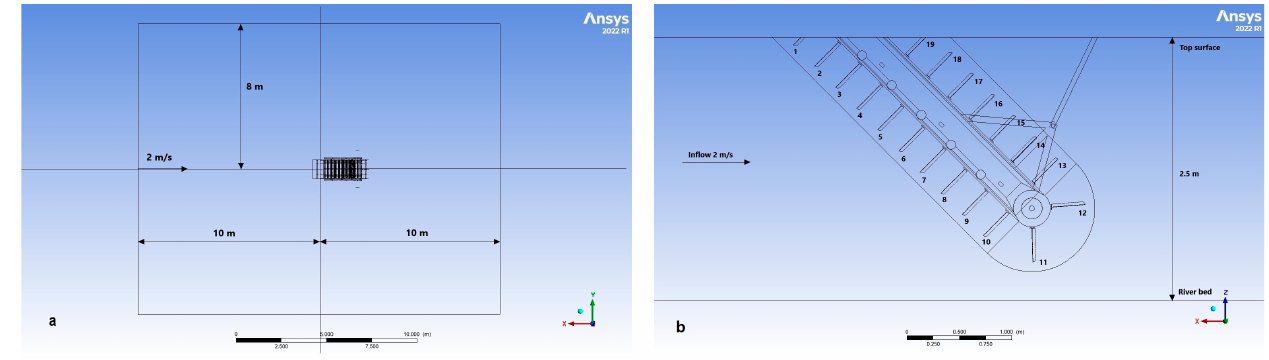
Figure 5. ( a ) Top view of simulation area; ( b ) Side view of simulation area and numbering of the blades.